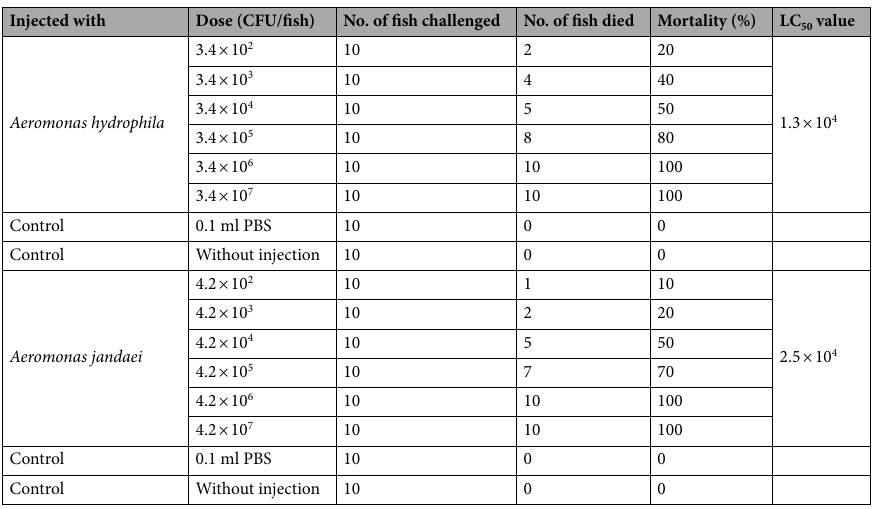
Table 2. Results of Aeromonas hydrophila (isolate AM-31) and A. jandaei (isolate AM-05)-induced pathogenicity in experimentally-challenged Anabas testudineus via intraperitoneal injection showing mortality within 15 days of infection.